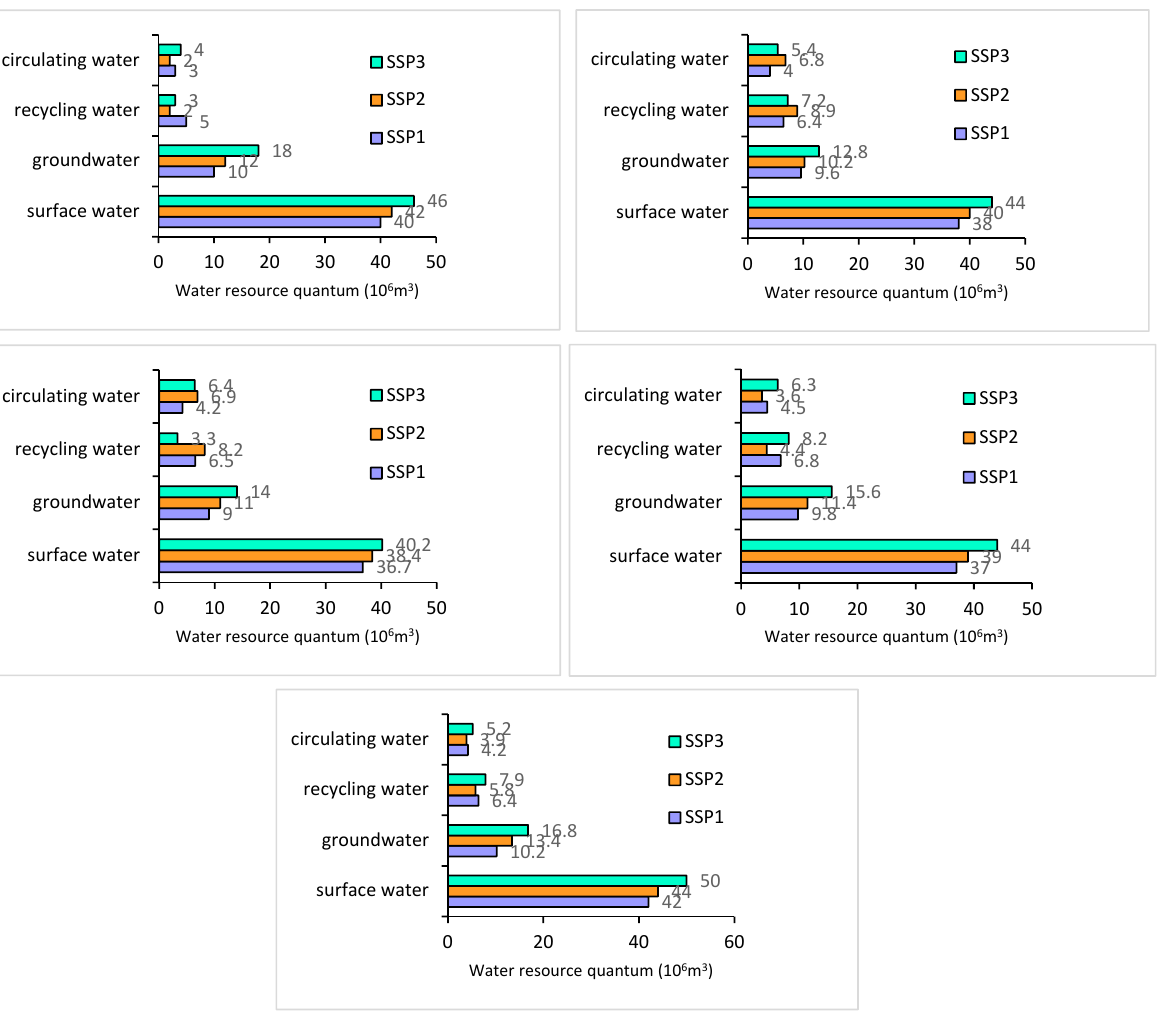
Figure 3. Results of multiple water sources optimal allocation in 2021–2025 under different SSPs.